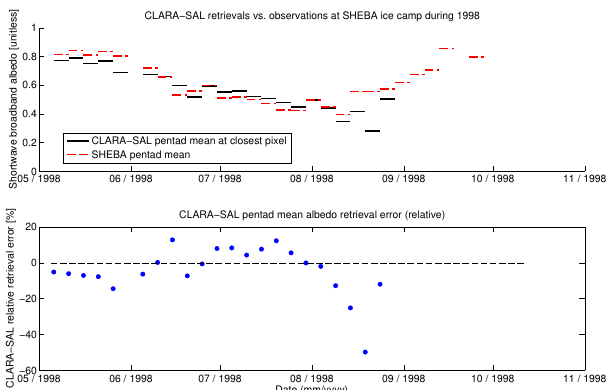
Fig. 6. Validation results of CLARA-SAL pentad means against corresponding in situ pentad albedo means at the SHEBA ice camp during 1998. Upper panel: Retrieved albedos. Lower panel: Relative retrieval accuracy of CLARA-SAL against in situ data.